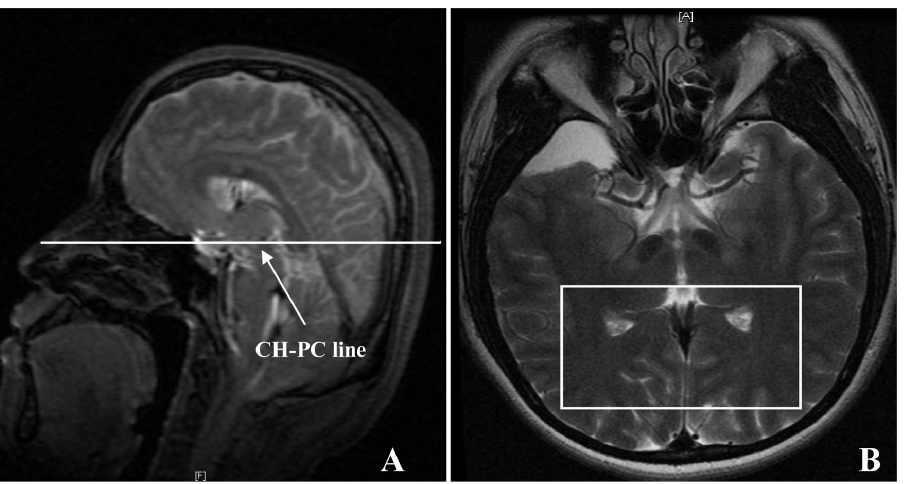
Figure 1. The volume of interest in multi-voxels 2D- 1 H-MRS. Figure 1A was the T 2 WI image of the median sagittal plane. The subject kept the lower jaw upwards to make the CH-PC line horizontal. Figure 1B The VOI (white box), including bilateral GCTs and the striate area, located in the axial